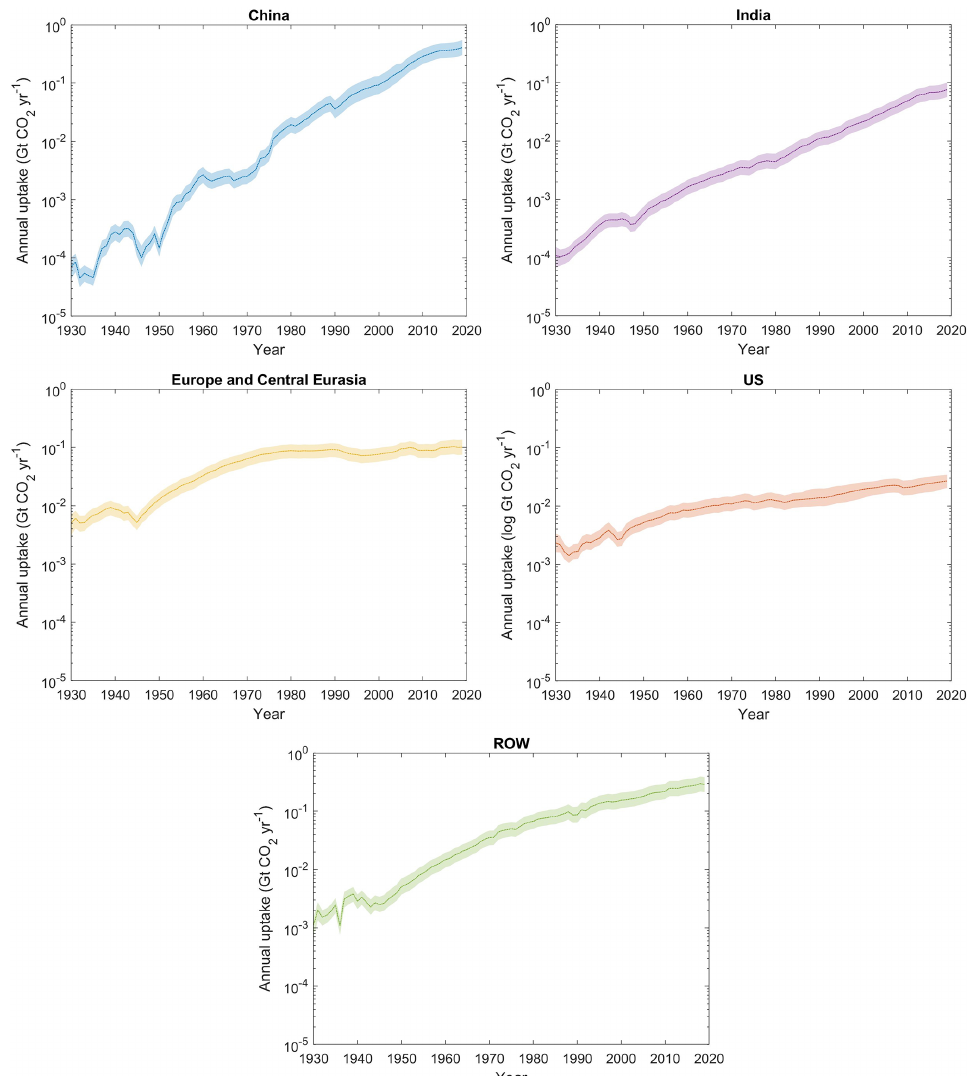
Figure 6. The increase in cement CO 2 uptake in China, India, Europe and central Eurasia, the US, and the rest of the world from 1930 to 2019. The y axes are plotted in logarithm scale (absolute value) and within the same range for comparison; both the median (dotted lines) and 95% CI (shaded area) are